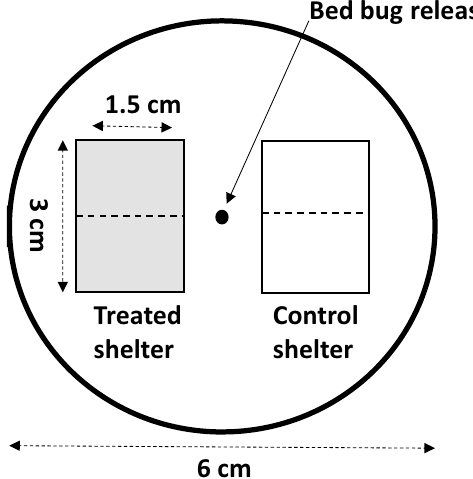
Figure 1. Two-choice behavioral assay (top-view) consisting of two equal size paper shelter tents. A clean filter paper (control) was always paired with a treated filter paper that either represented a human skin swab,